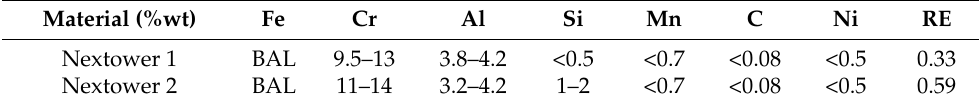
Table 1. Nominal chemical composition of the two alloys, Nextower 1 and Nextower 2, developed for liquid-lead corrosion resistance. RE = rare earths. All values are given in wt%.